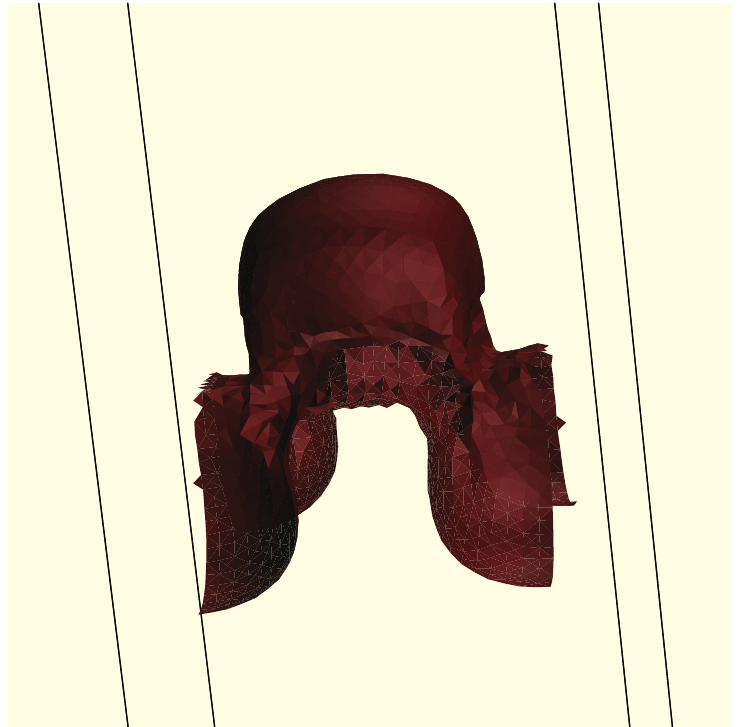
Figure 3: Plot of early time for Rayleigh-Taylor fl uid instability. Flow and grid parameters as in Figure 2.